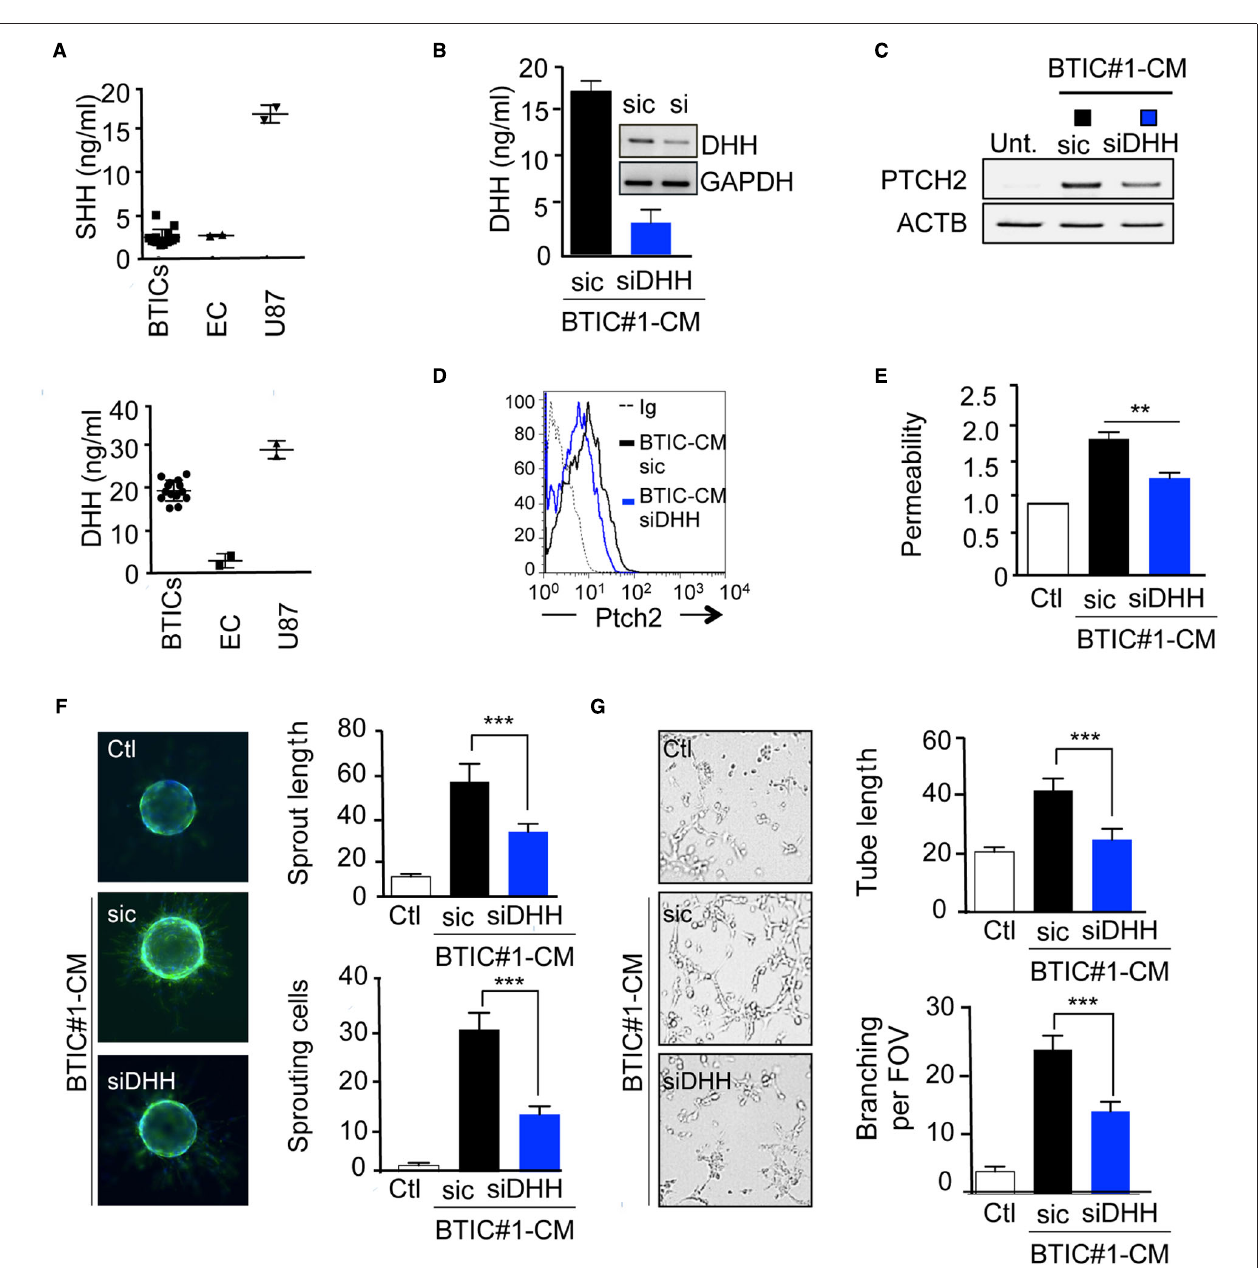
FIGURE 3 | DHH mediates the BTICs-CM effects in brain endothelial cells. (A) SHH and DHH secretion was examined by ELISA in BTICs and endothelial cells (EC) conditioned media. U87 were used as a positive control. (B) BTICs cells were transfected with either control (sic) or siRNA against DHH (siDHH). Conditioned media was collected and processed for DHH secretion by ELISA assay. Alternatively, mRNA were extracted from both sic and siDHH receiving cells, and DHH expression was assessed by RT-PCR. GAPDH was used as a reference gene. (C–G) Confluent monolayers of hCMEC/D3 cells were exposed for 24 h to BTICs-conditioned media depleted (siDHH) or not (sic) for DHH. Ptch2 expression was assessed by RT-PCR (C) and flow cytometry analysis (D) . Dashed histograms correspond to the isotype-matched control (Ig), black and blue histograms show antibody staining in endothelial cells treated as indicated. (E) Permeability of endothelial cells was analyzed. (F,G) Endothelial cells were also tested for their sprouting (F) and tube formation (G) ability. The number of sprouting cells and mean sprout length were determined in (F) . Tube length, and number of branch points were counted in (G) . *** p < 0.001, ** p < 0.01 by analysis of variance (ANOVA). Each panel is representative of at least two independent